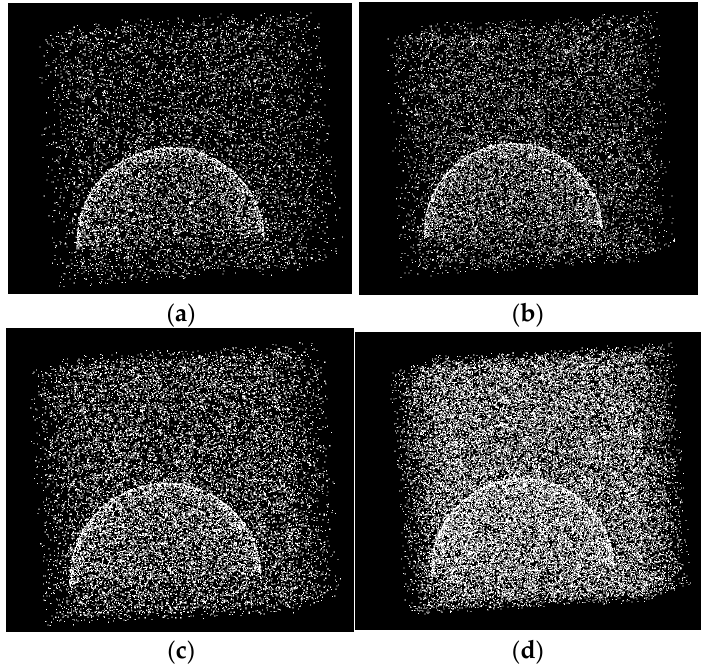
Figure 4. Point cloud of noisy spherical surface at different scales. ( a ) The proportion of the number of point clouds to noise points in the spherical model is 10%; ( b ) the proportion of the number of point clouds to noise points in the spherical model is 20%; ( c ) the proportion of the number of point clouds to noise points in the spherical model is 30%; ( d ) the proportion of the number of point clouds to noise points in the spherical model is